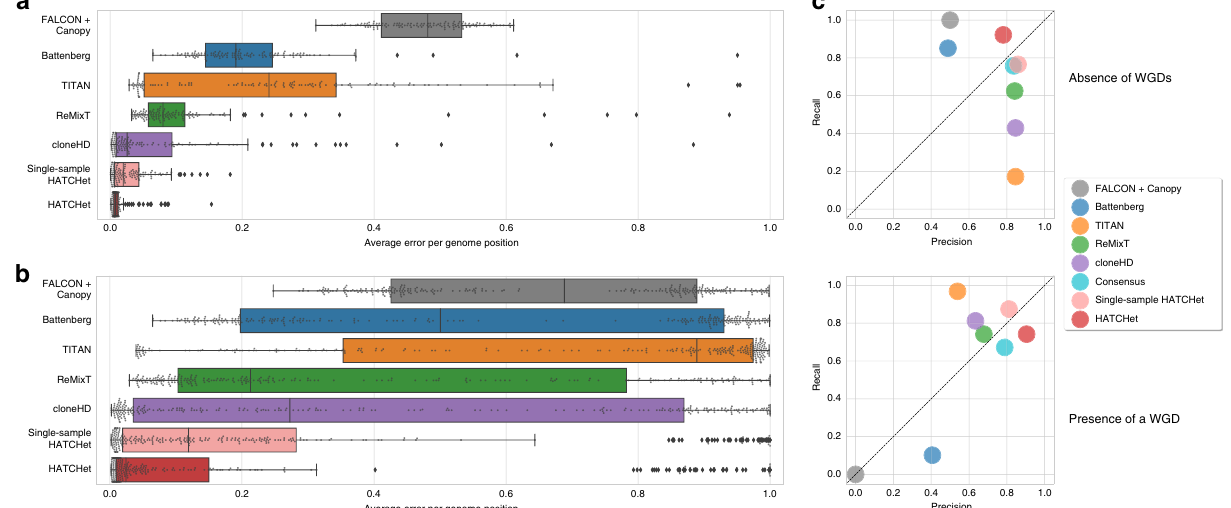
Fig. 2 HATCHet outperforms existing methods in the inference of CNAs, their proportions, and WGDs. a Average allele-speci fi c error per genome position for the copy-number states and their proportions inferred by each method (here excluding THetA which does not infer allele-speci fi c copy numbers) on 128 simulated tumor samples from 32 patients without a WGD, and where each method was provided with the true values of the main parameters (e.g., tumor ploidy, number of clones, and maximum copy number). HATCHet outperforms all the other methods even when it considers single samples individually (single-sample HATCHet). b Average allele-speci fi c error per genome position on 256 simulated tumor samples from 64 patients, half with a WGD, and where each method infers all relevant parameters including tumor ploidy, number of clones, etc. HATCHet outperforms all the other methods, even when considering single samples individually (single-sample HATCHet). Box plots show the median and the interquartile range (IQR), and the whiskers denote the lowest and highest values within 1.5 times the IQR from the fi rst and third quartiles, respectively. c Average precision and recall in the prediction of the absence of a WGD and the presence of a WGD in a sample. HATCHet is the only method with high precision and recall (>75%) in both the cases, even compared to a consensus of the other methods based on a prediction for majority. While Battenberg and Canopy underestimate the presence of WGDs (<20% and 0% recall), TITAN, ReMixT, and cloneHD overestimates the absence of WGDs (<20%, <62%, and <50%